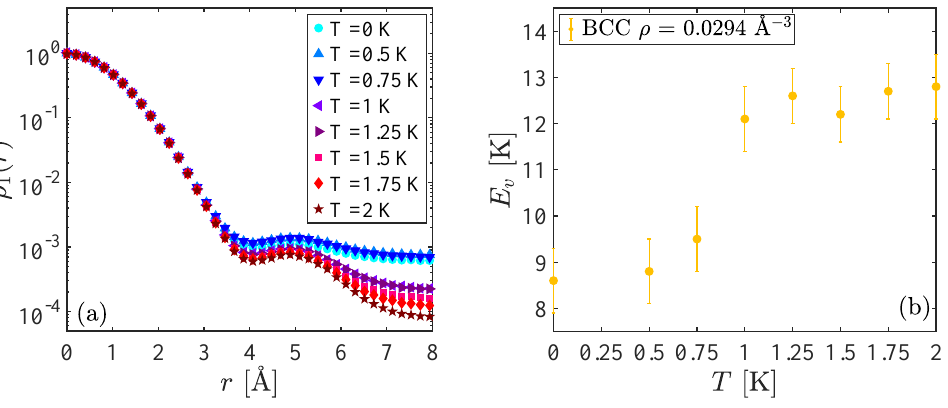
Figure 3. Results for a bcc crystal at density ρ = 0.0294 Å − 3 : ( a ) one-body density matrix ρ 1 ( r ) as a function of the interatomic distance r , for different values of the temperature T (error bars are below symbol size); and ( b ) vacancy formation energy E v as a function of the temperature.